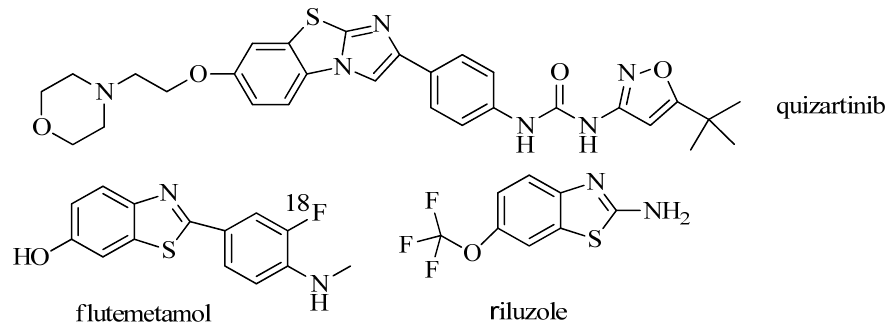
Figure 1. Approved drugs with benzothiazole scaffold. Figure 1 . Approved drugs with benzothiazole scaffold. Figure 1 . Approved drugs with benzothiazole scaffold.